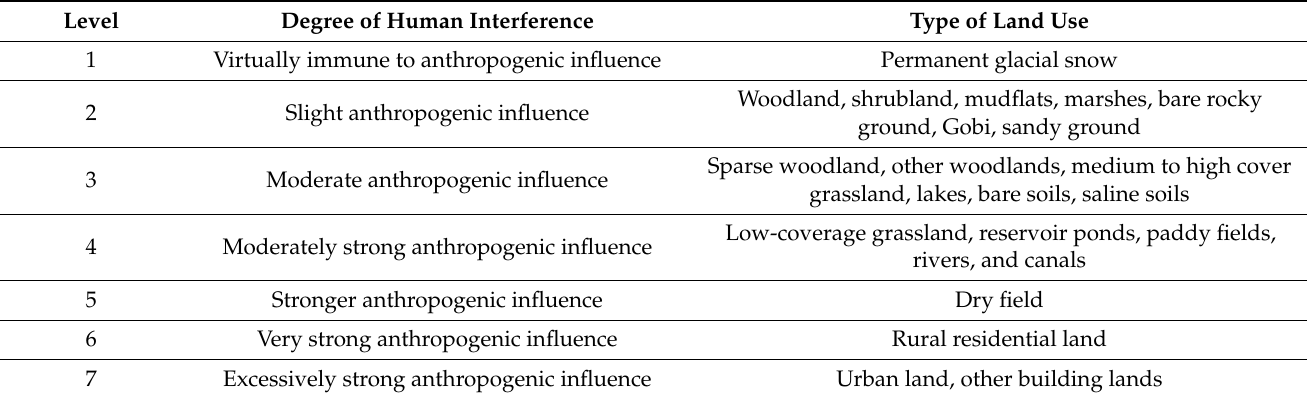
Table 4. Degree of human interference vs. LULC comparison